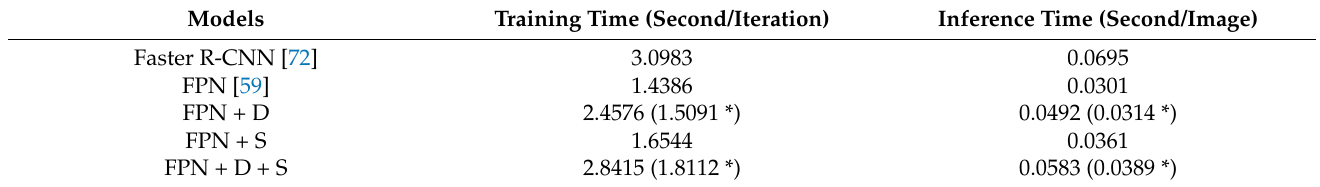
Table 3. Efficiency comparison. *: Model parallelism on two GPUs.